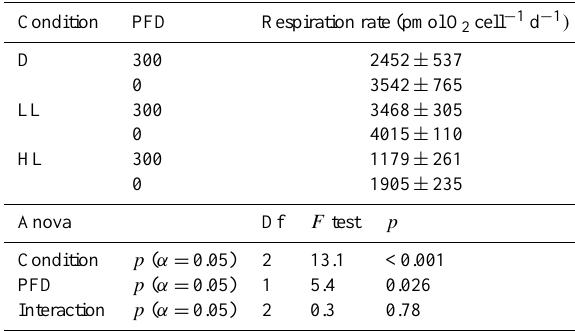
Table 1. Light and dark respiration rates (pmolO 2 cell − 1 d − 1 ) ± SD of Haynesina germanica in the three experimental conditions (Dark, Low Light and High Light) at the end of the experiment (Df, degree of freedom, PFD photon flux